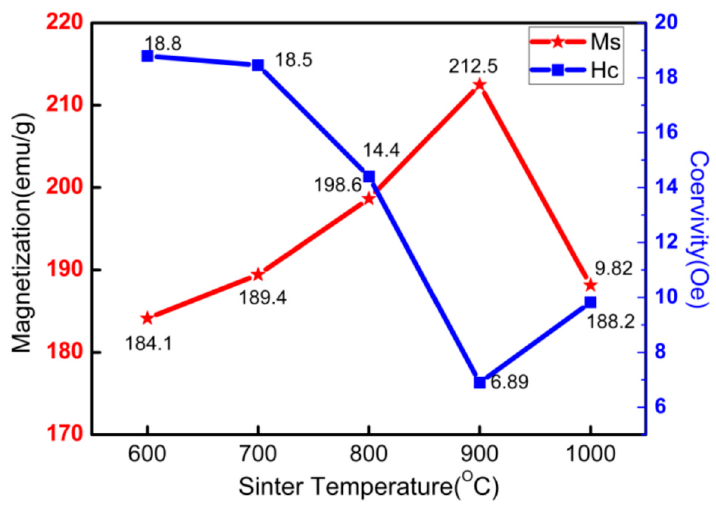
Figure 12. The Fe-Si/MnZn(Fe 2 O 4 ) 2 composite of the saturation magnetization (Ms) and coercivity(Hc) values. Table 2. Main magnetic parameters of our specimens and other